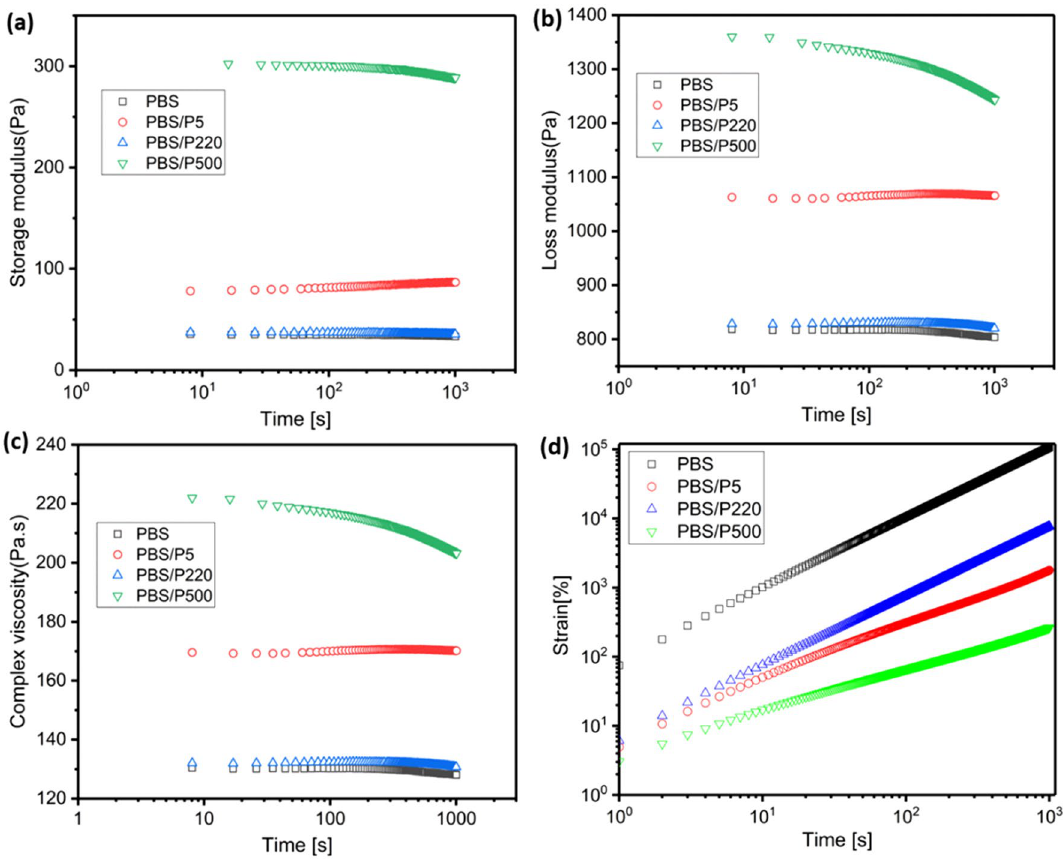
Figure 8. Time sweep curves of rheology: ( a ) storage modulus (G ′ ), ( b ) loss modulus (G ″ ) and ( c ) the complex viscosity (η*); ( d ) creep curves in the molten state of PBS and PBS/PTFE